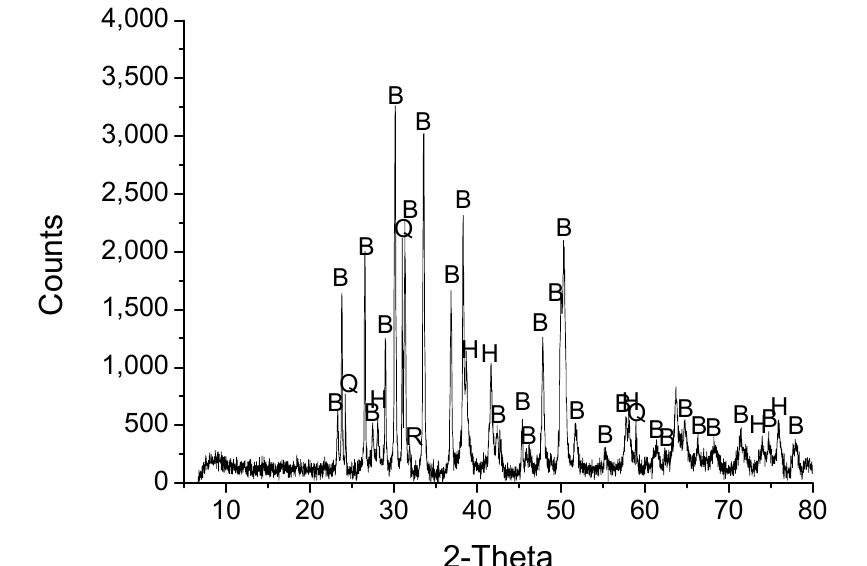
Figure 13. X-Ray diffraction of the solid residue of the aqueous leaching step of run 12 (H—hematite, R—rutile, B—barite, Q—quartz).